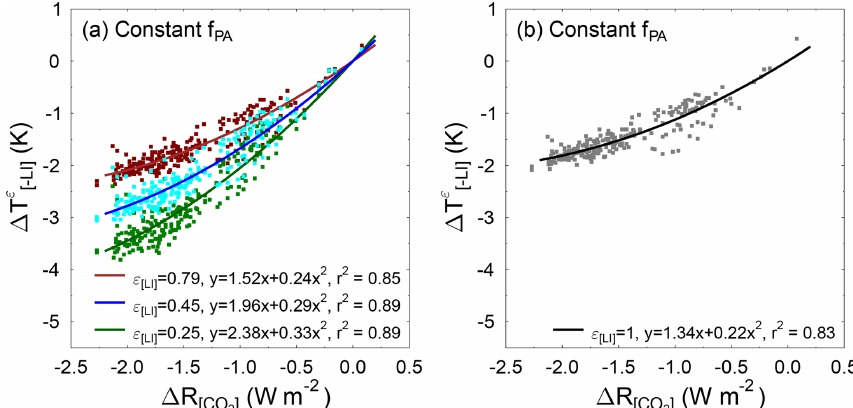
) calculated using Eq. (16) against LI ]